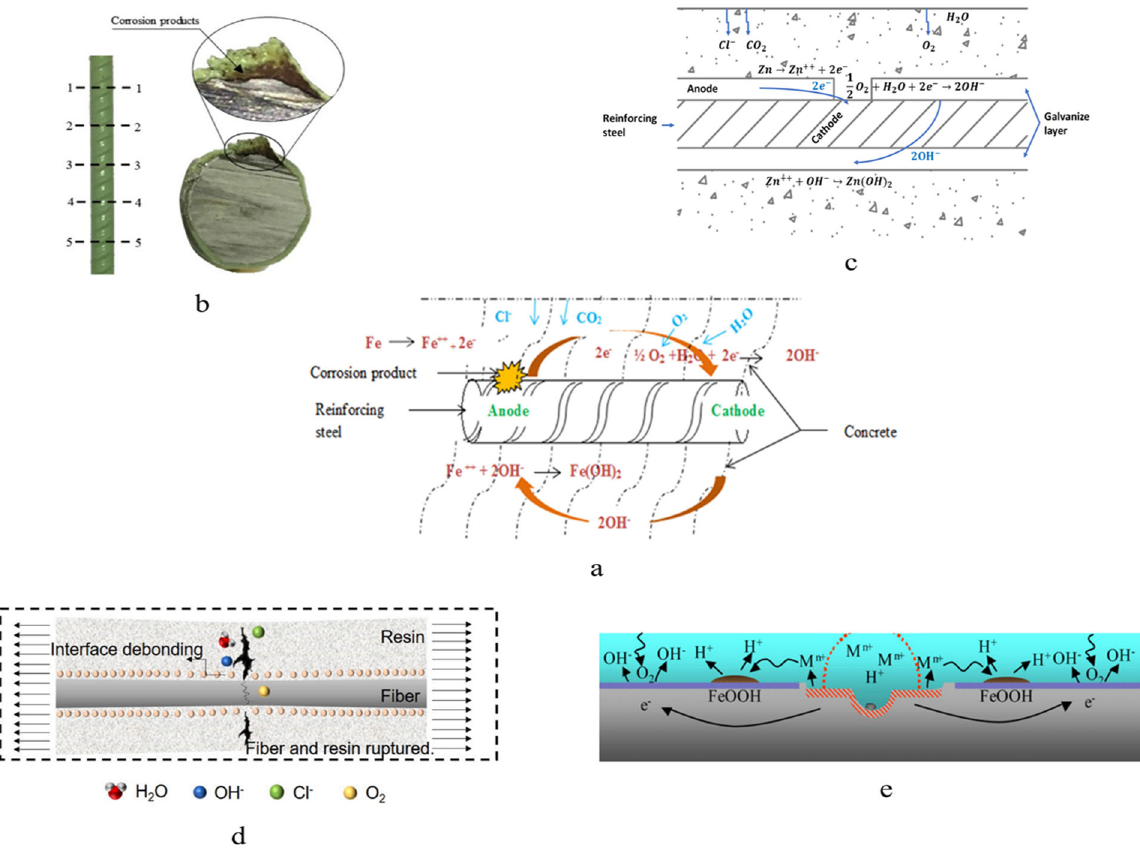
Figure 7. Corrosion mechanism of the ( a ) BSR, ( b ) ECR, ( c ) GR, ( d ) FRP bar, ( e ) Stainless reinforcement [2,30,111,123,128].